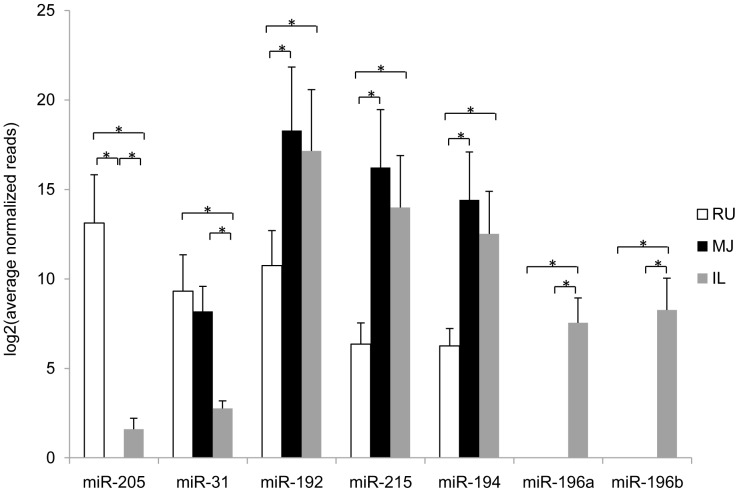
Expression levels of the most significant regionally DE miRNAs detected by miRNA sequencing in rumen (RU, open bar), mid-jejunum (MJ, solid black bar) and ileum (IL, solid grey bar).“*” represents miRNA differentially expressed between two tissues (FDR <0.05, >1.5 fold). No bar is shown when miRNA expression was not detected.